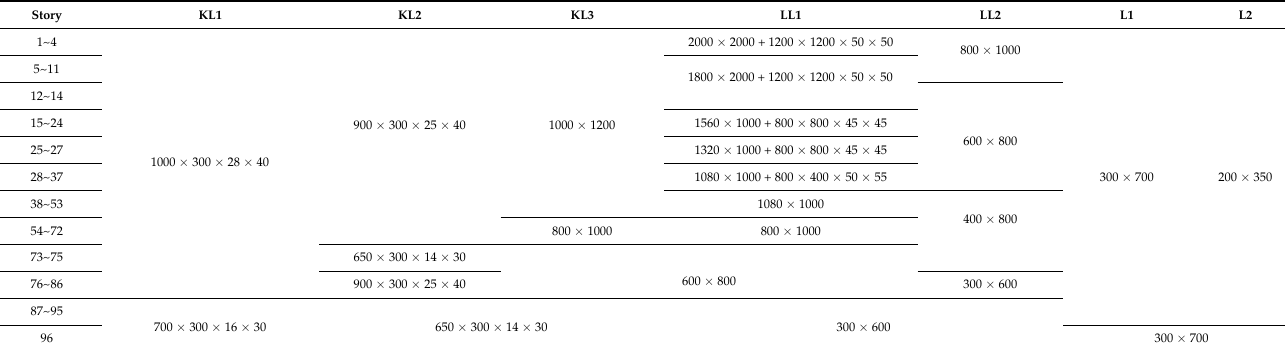
Figure 12. Typical floor plan layout of the case-study building (unit: mm). Table 4. Member size of horizontal components (unit: mm).